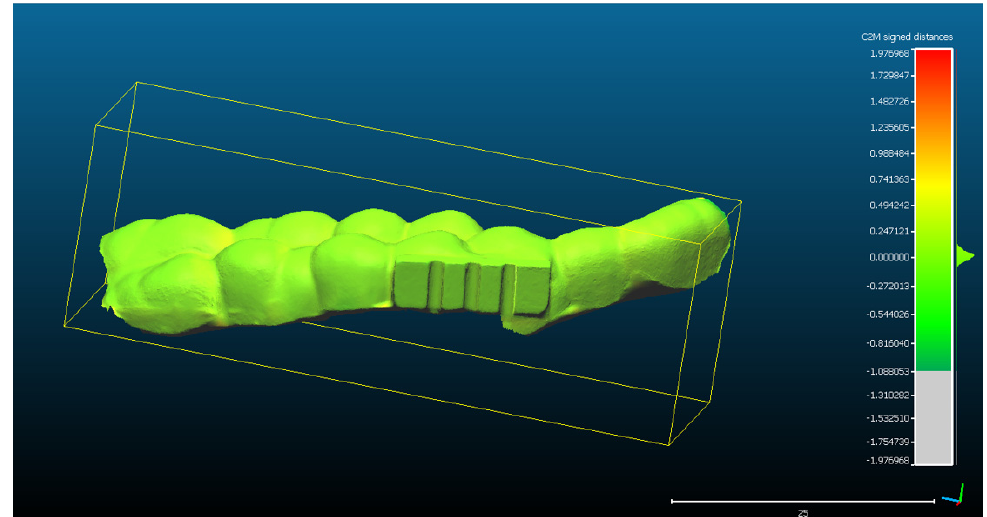
Figure 4. The spatial distribution of the 128,570 measurements between the optical scan of the mouth guard with the reference object (CAD project STL format) after alignment. The distribution of the alignment errors is figured in the form of a colored Gaussian shape on the right side of the color code bar. In light green are the measurements close to 0.